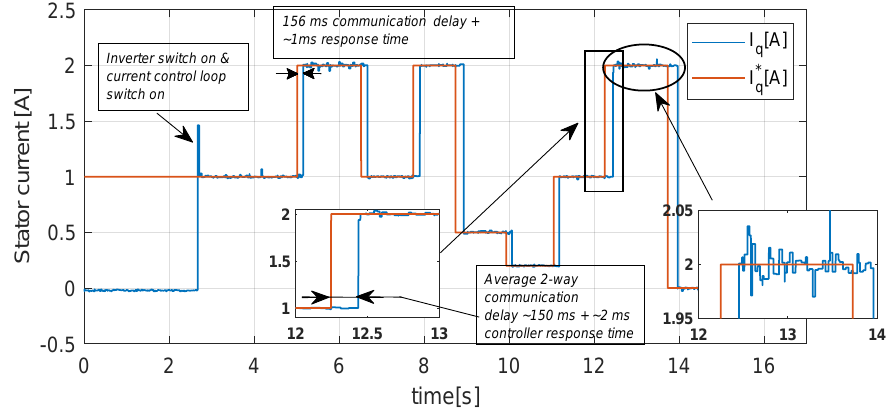
Figure 7. Stator quadrature current (experimental test